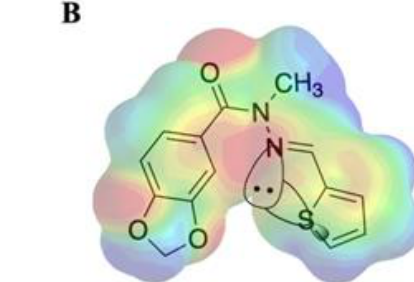
Figure 2. Representation of chalcogen interaction between the electron pair of the iminic nitrogen and the antibonding orbital in the thiophene ring. ( A ) Electrostatic potential map of LASSBio-294 ( 1 ); ( B ) Electrostatic potential map of LASSBio-785 ( 2 ). Red shadow represents the negatively charged area; blue shadow represents the positively charged area.